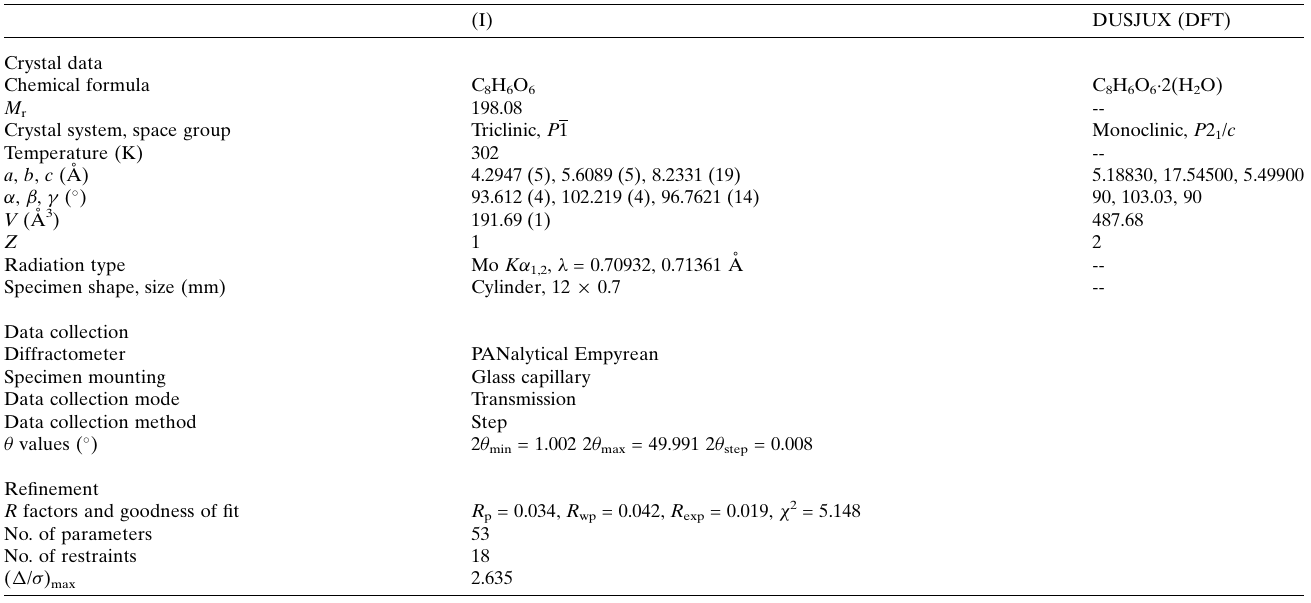
Table 3 Experimental details.